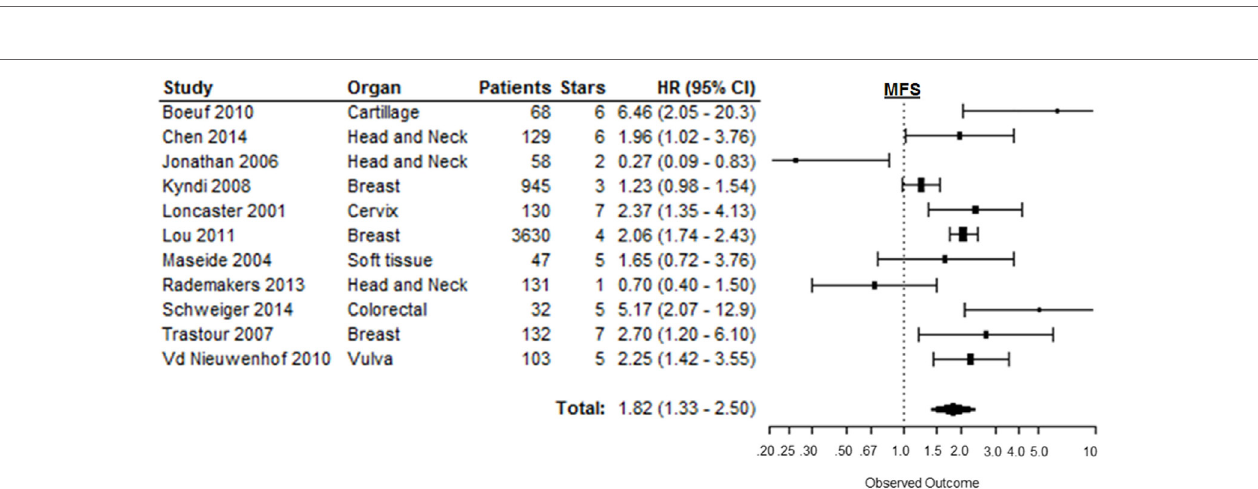
FiGURe 6 | Forest plot of the papers describing the association between CAiX expression and DSS . Horizontal bars represent HR with corresponding 95%CI. Symbol size represents the assigned weight of the study. The overall HR with 95%CI is visualized with the diamond shape. Dashed line indicates no association between CAIX and prognosis (29, 78, 95, 102, 136, 138, 140, 144, 150, 152, 154, 156–165).